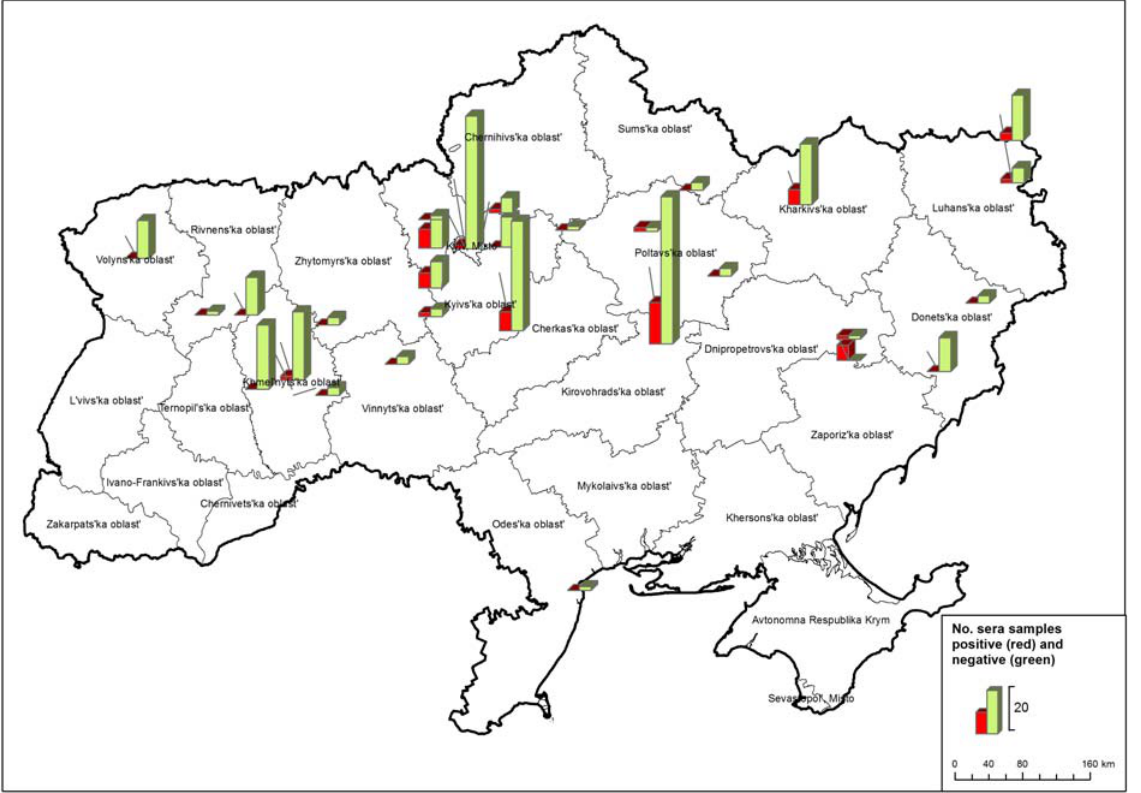
Figure 3. Number of WNV positive sera (red columns = both in ELISA and NT) in horses from different Ukrainian regions. ELISA negative samples are depicted in green columns.